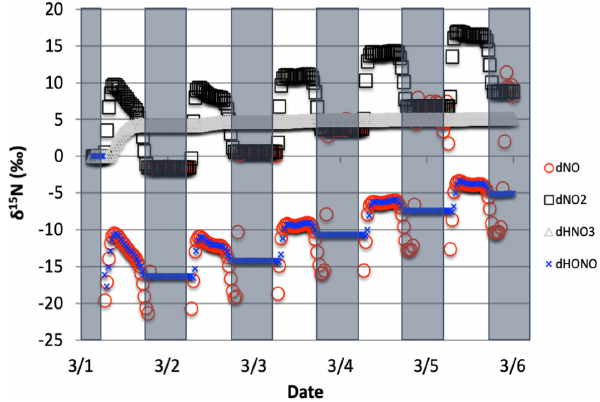
Figure 1. The time evolution of δ 15 N values of NO, NO 2 , HONO, and HNO 3 , caused by the NO 3 + NO → NO 2 + NO 2 reaction (Re- action R51, 51a). This reaction only induces a δ 15 N variation of ± 0 . 005‰ in the relevant compounds. Thus, this reaction is consid- ered irrelevant and i N RACM sets R51a α = 1 . 0.